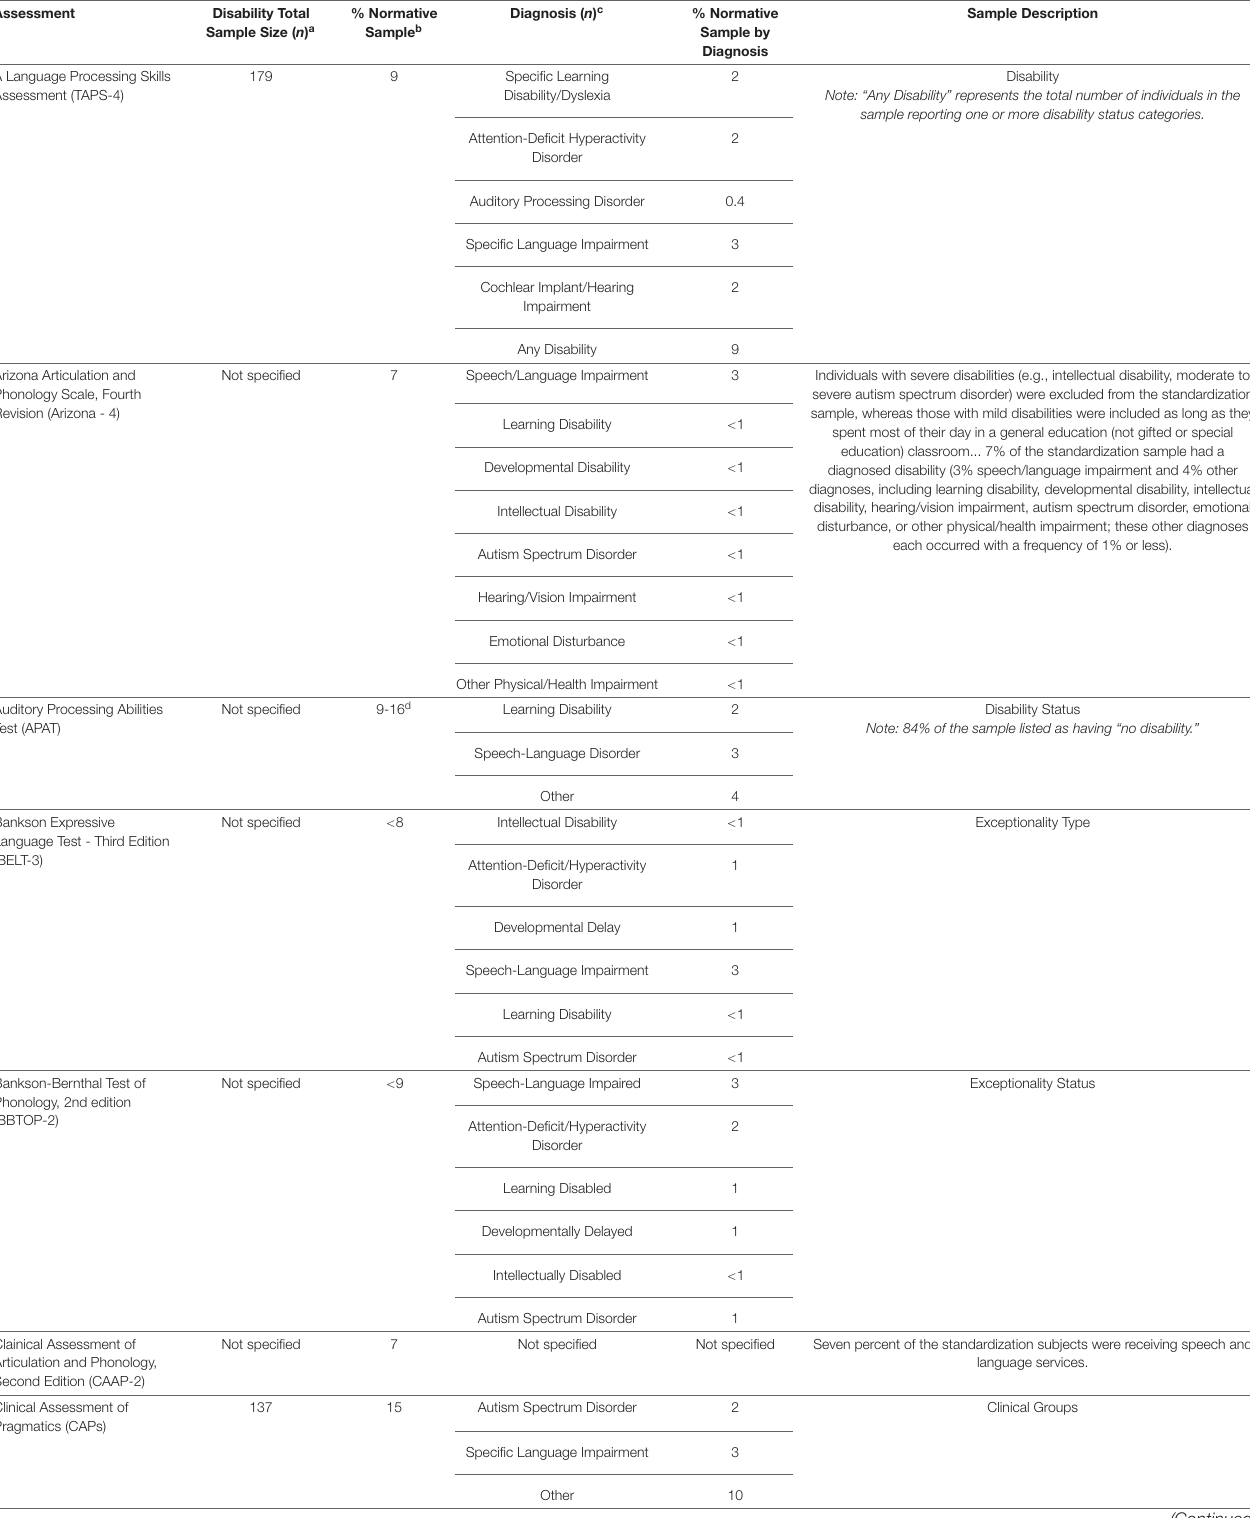
TABLE 2 | Individuals with disabilities in normative samples.